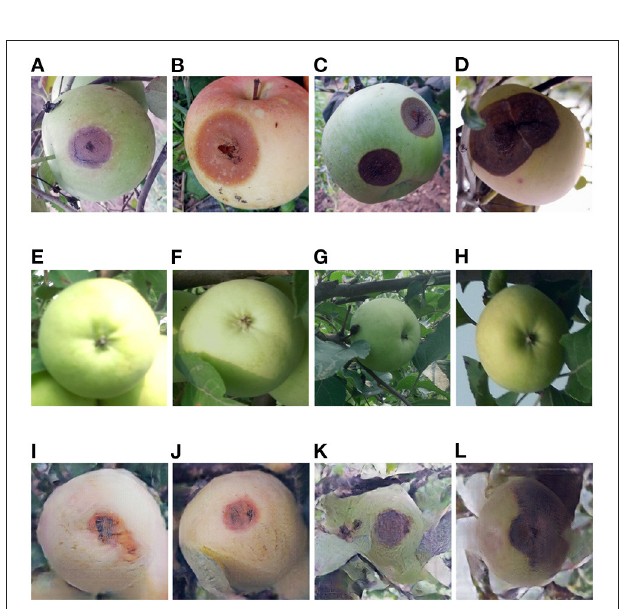
FIGURE 9 | (A–D) Ring rot apple images captured in field, (E–H) healthy apple images, (I–L) ring rot apple images converted from the above healthy apple images by the Cycle-GAN